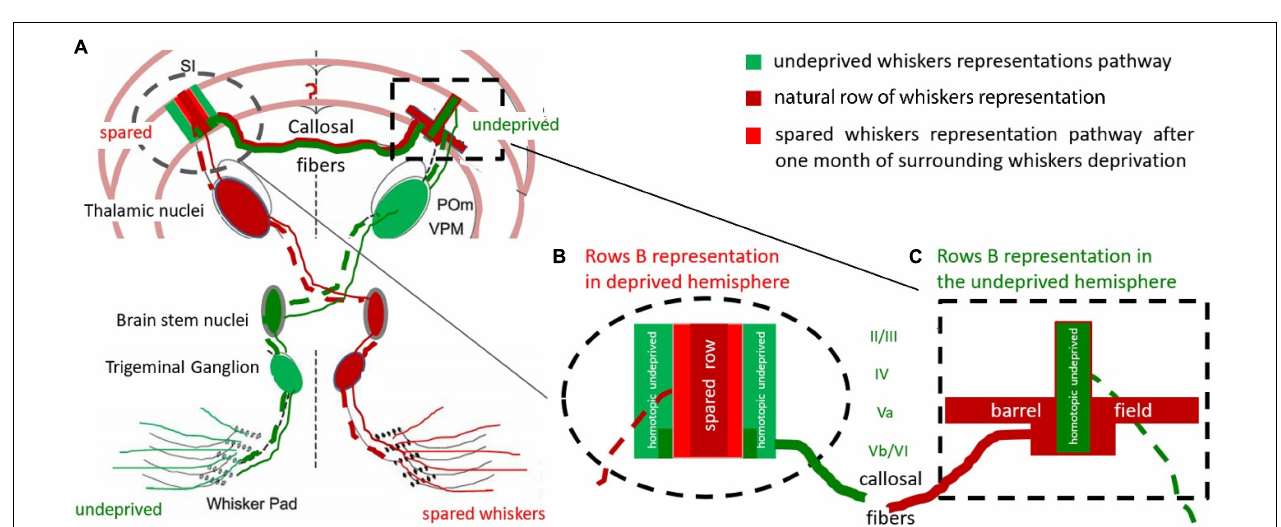
FIGURE 5 | Hypothetical reconstruction of the ExDP in the cortex of BF. (A) Whiskers-BF pathway. The cortical row of whiskers’ representations shows the profile of the activation perpendicular to the row during bilateral whiskers stimulation of spared and homotopic contralateral row of whiskers; (B) cortical representation of a spared row of whiskers. (C) BF with contralateral, homotopic to the spared row of whiskers, row B cortical representation (green), and spread activation in response to ipsilateral spared whiskers stimulation (red); Red: response to unilateral, spared whiskers’ stimulation, from the deprived whisker pad; Dark red: response typical to the stimulation of undeprived row of whiskers (when the whisker pad is intact); Green: undeprived whiskers activity effects in deprived animals during bilateral homotopic rows stimulation (the undeprived and spared one). The homotopic undeprived row B stimulation effect on (the green on Figure 5B ) is supposedly the transcallosal inhibition from activated during the deprivation period homotopic to the spared one row of whiskers. dashed line – contralateral whiskers-BF pathway; solid line – ipsilateral pathway; POm – Posteromedial nucleus; VPM – ventroposteromedial nucleus. Adapted from Shuler et al.,